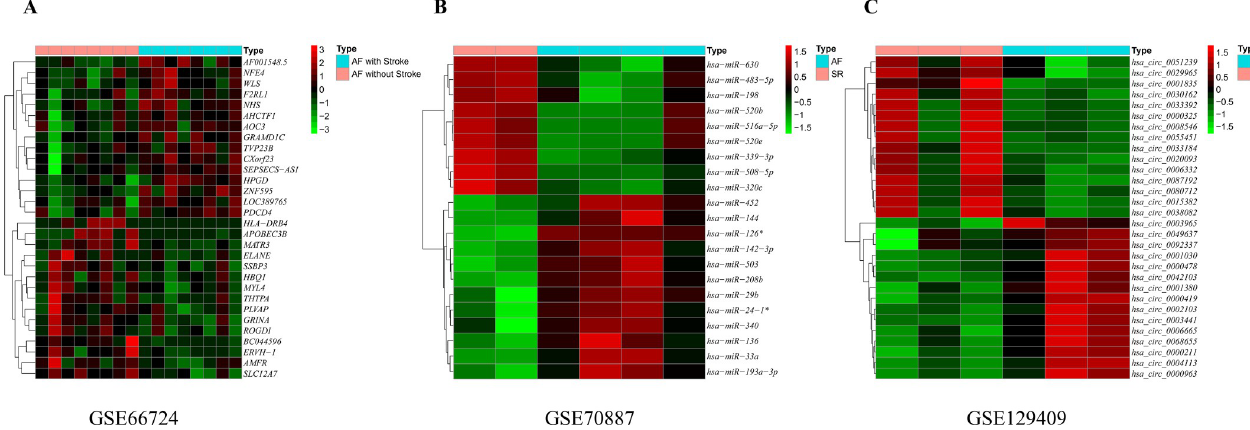
Fig 3. Identification of differentially expressed genes. Heatmap of the top 30 differentially expressed genes based on A GSE66724, B GSE70887, and C GSE129409. The color intensity (from red to green) suggests the higher to lower expression.